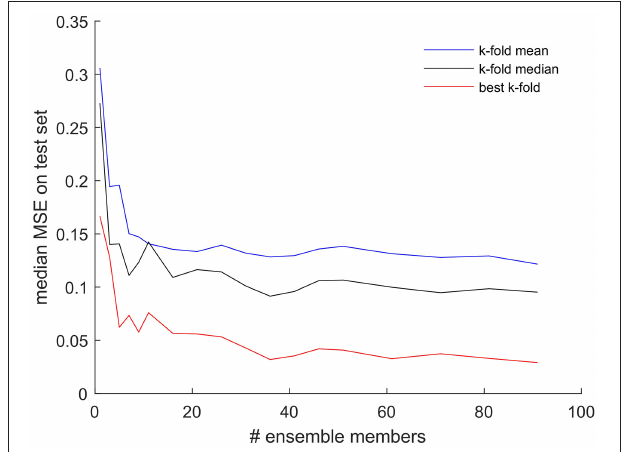
FIGURE 3 | Test set MSE of the best model within an ensemble as a function of the number of ensemble members. The results displayed are the median of 10 replicates performed for each number of ensemble members. All results obtained while applying the three-fold cross-validation procedure for every model. Red line shows the results from choosing the best of the three-folds, black line—median of the three-folds, blue line—mean of the three-folds, for each individual ensemble member